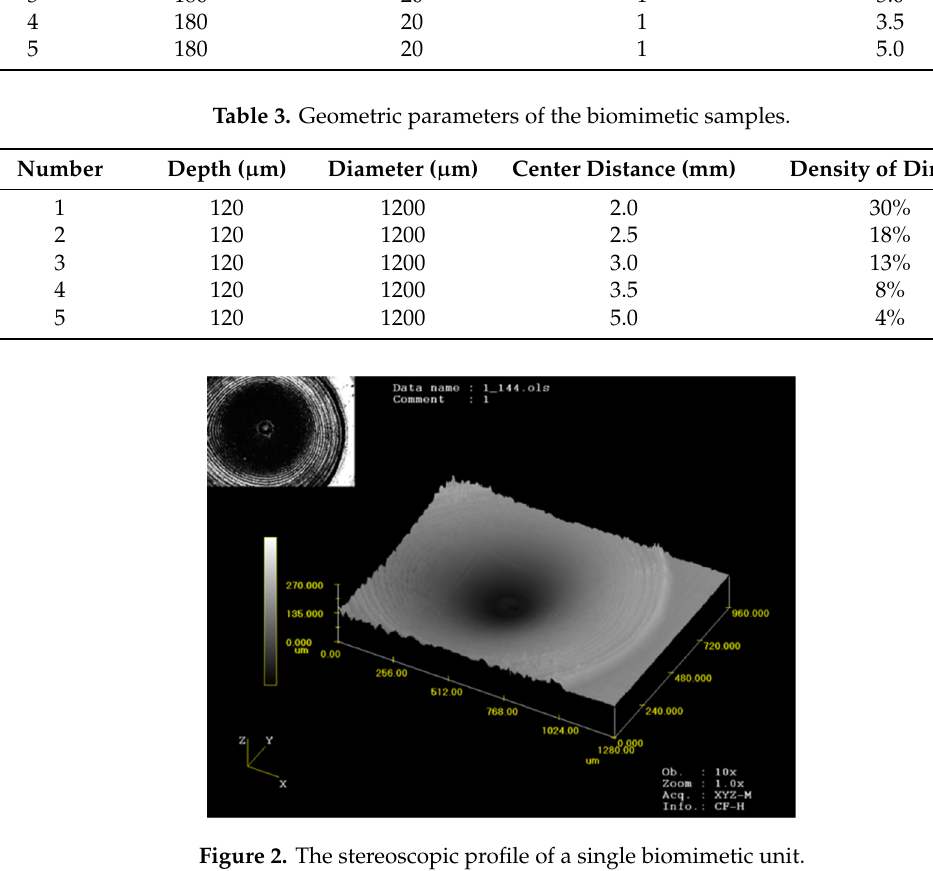
Table 2. Processing parameters of the biomimetic samples.